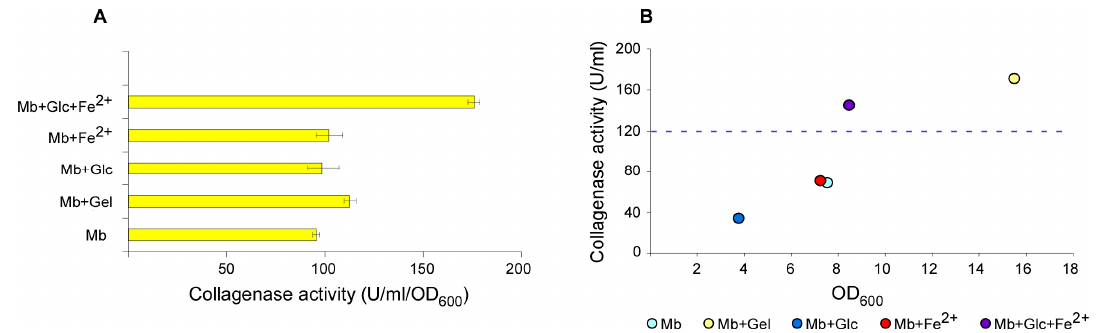
Figure 3. Collagenase production from V. parahaemolyticus with combinations of non-animal inducers. V. parahaemolyticus was grown overnight in the specified liquid media and collagenase activity measured by colorimetric test, using bovine insoluble collagen as substrate. Collagenolytic activity normalized with cell density ( A ) and trend of collagenolytic activity with cell density ( B ).